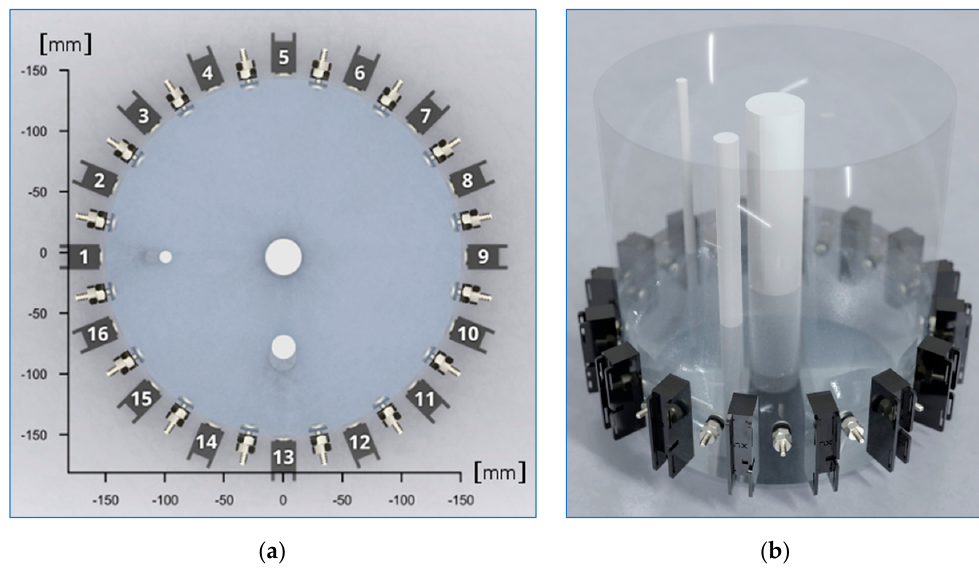
Figure 12. Model of the tested object with three inclusions: ( a ) 2D top view, ( b ) 3D side view.